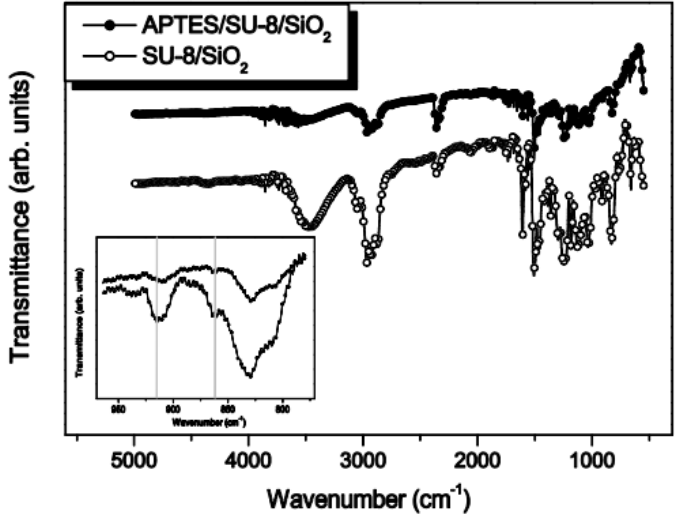
Figure.4. FT-IR spectra of SU-8 (2025) before and after silanization treatment. The inset shows the expanded spectral region between 960 cm −1 and 780 cm −1 , the intensity of epoxy group related vibrational resonances at 867 cm −1 , and 917 cm −1